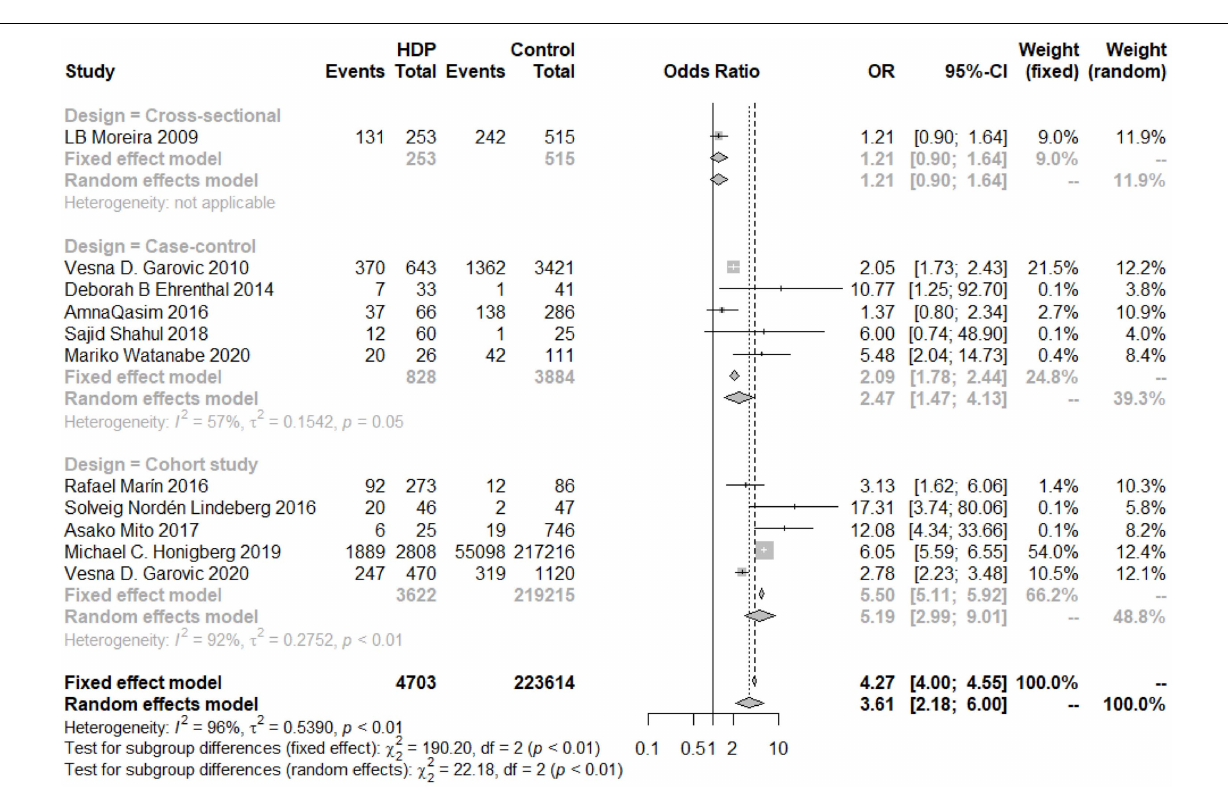
FIGURE 8 | Subgroup analysis by the study design of the risk of developing chronic hypertension in the HDP group.